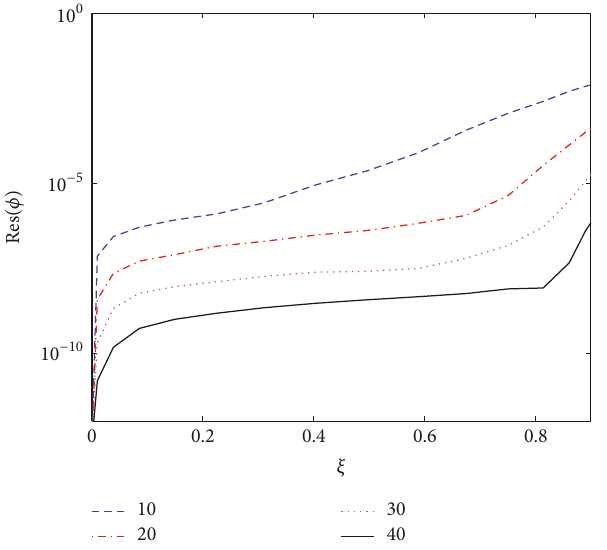
Figure 8: Residual error in 𝜙(𝜂,𝜉) against 𝜉 at different iteration levels ( 𝜆 = 1, 𝜎 = 𝛾 = 0.5, Pr = 3, Sc = 2, ℏ = −0.5 ).